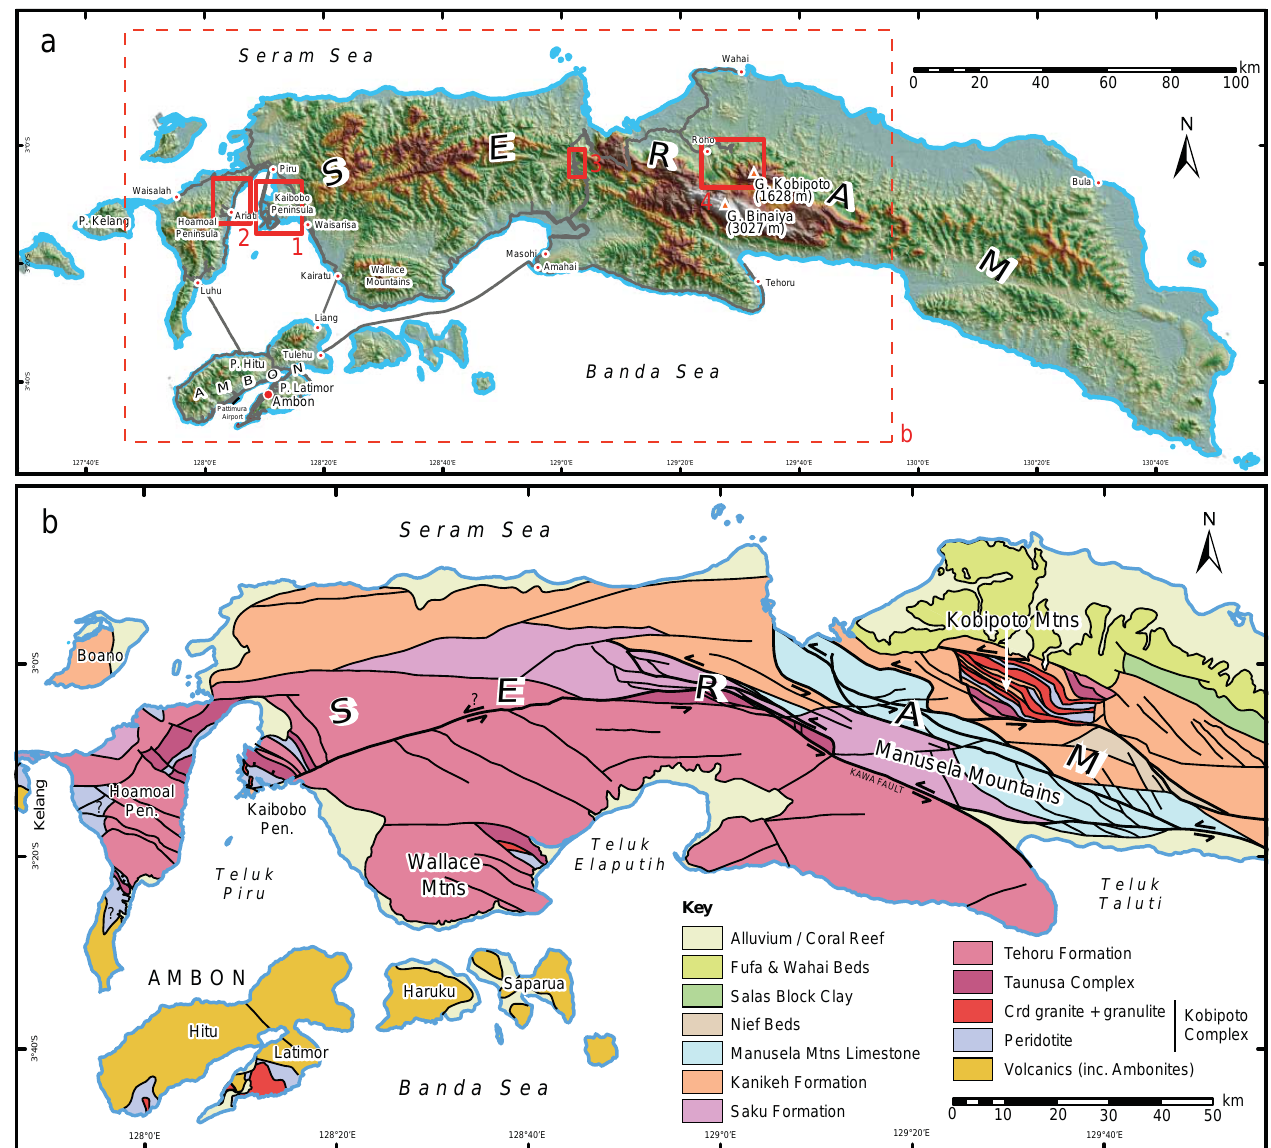
Fig. 3. (a) SRTM image of Seram and Ambon. Red boxes show the locations of the included maps: (1) Kaibobo Peninsula – see Fig. 5; (2) NW Hoamoal Peninsula – see Fig. 9; (3) Central Kawa Fault Zone – see Fig. 11; (4) Kobipoto Mountains – see Fig. 14. The dashed red box shows the location of map (b) . (b) Geological sketch map of western and central Seram and Ambon compiled from new geological field mapping, DEM fault interpretation, and previously published maps (Valk, 1945; Germeraad, 1946; Tjokrosapoetro et al., 1993a, b). The schematic logs presented in Fig. 4 are shown in the same colour schemes to allow direct correlation with the